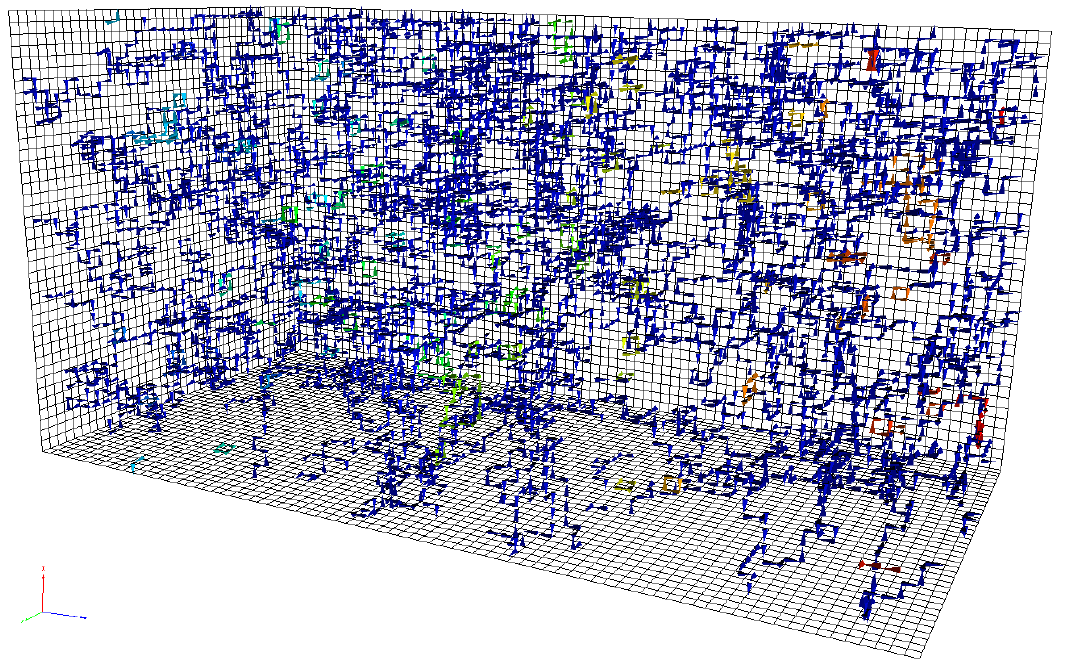
Figure 3: The centre-vortex structure of a ground-state vacuum field configu- ration in dynamical 2 + 1 flavour QCD. ( Click to activate. ) The flow of + 1 centre charge through a gauge field is illustrated by the jets. Symbols are as described in Fig. 2.